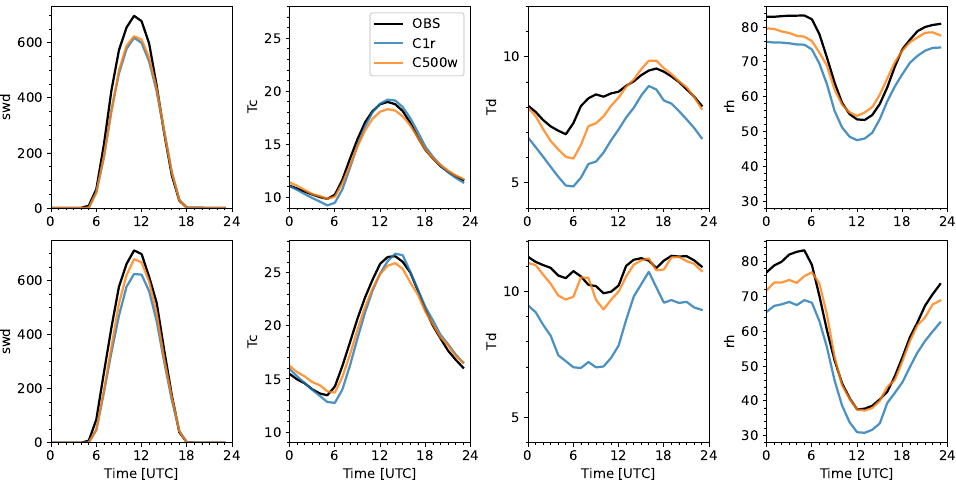
Figure 3. Mean diurnal cycle of key surface variables averaged over the valley wind days in Septem- ber 2016 from observations and simulations, averaged over the valley wind stations ( top row ) and for Sion ( bottom row ). The variables shown include the incoming solar radiation (swd), the 2 m temperature (Tc), the 2 m dew point temperature (Td), and the 2 m relative humidity (rh).